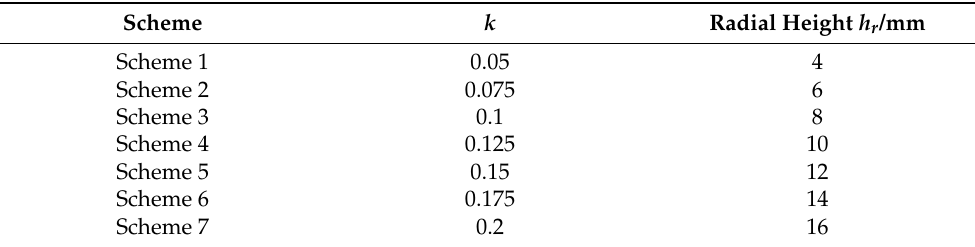
Table 2. Parameters of the radial height of helical static blade in different schemes.